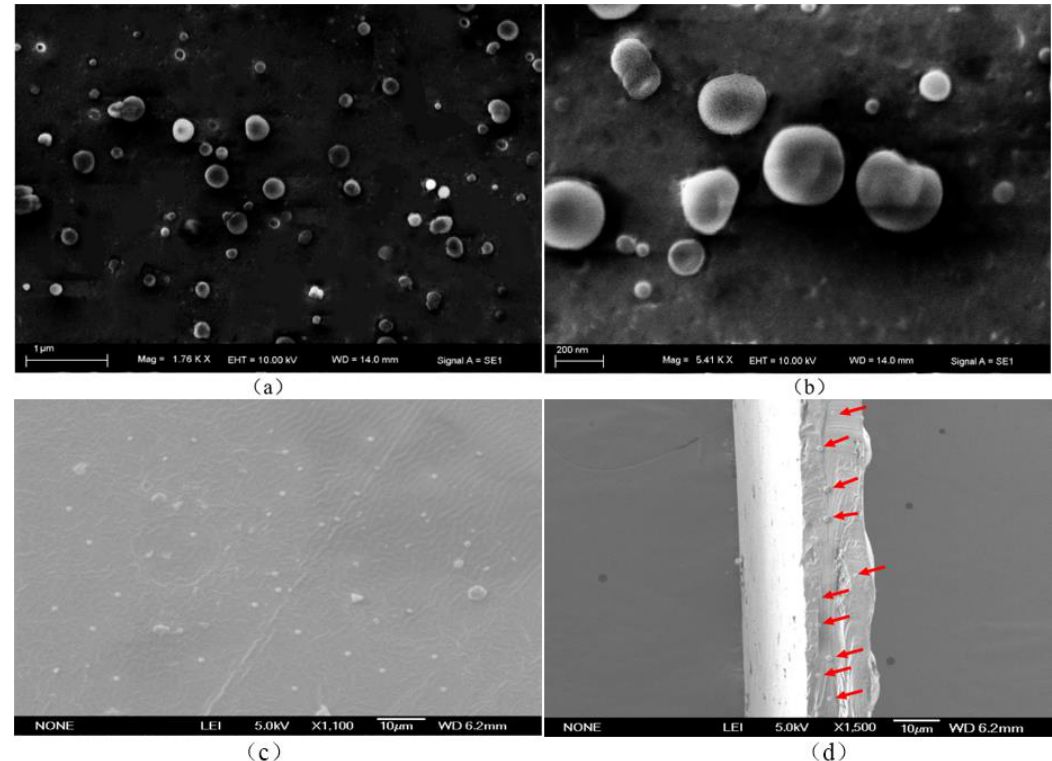
Figure 3. SEM images of ( a ) microcapsules (magnification: 1760×), ( b ) microcapsules (magnification: 5410×), ( c ) ginger essential oil microcapsule films (surface morphology), and ( d ) ginger essential oil microcapsule films (section morphology).